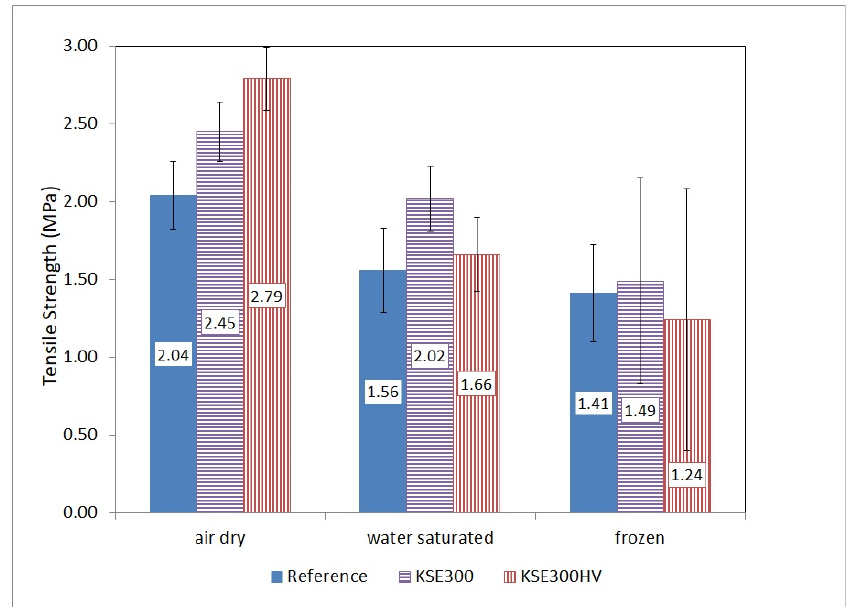
Figure 12. Tensile strength of untreated and treated Fert ő rákos limestone (FR) in air dry, water- saturated conditions and after 10 freeze–thaw cycles.